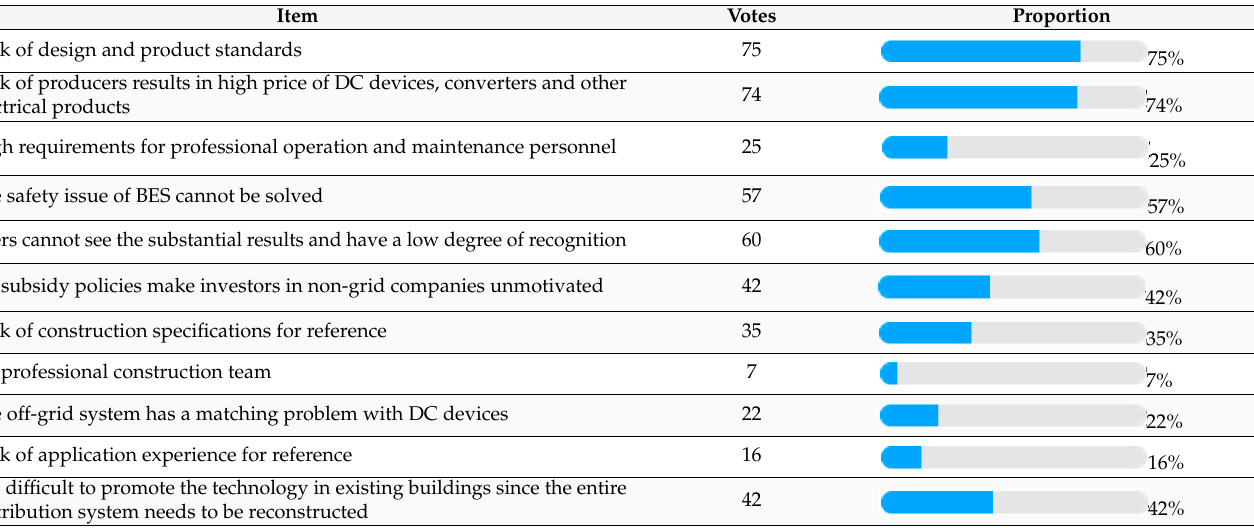
Table 4. Technical barriers to the promotion of LVDC buildings.